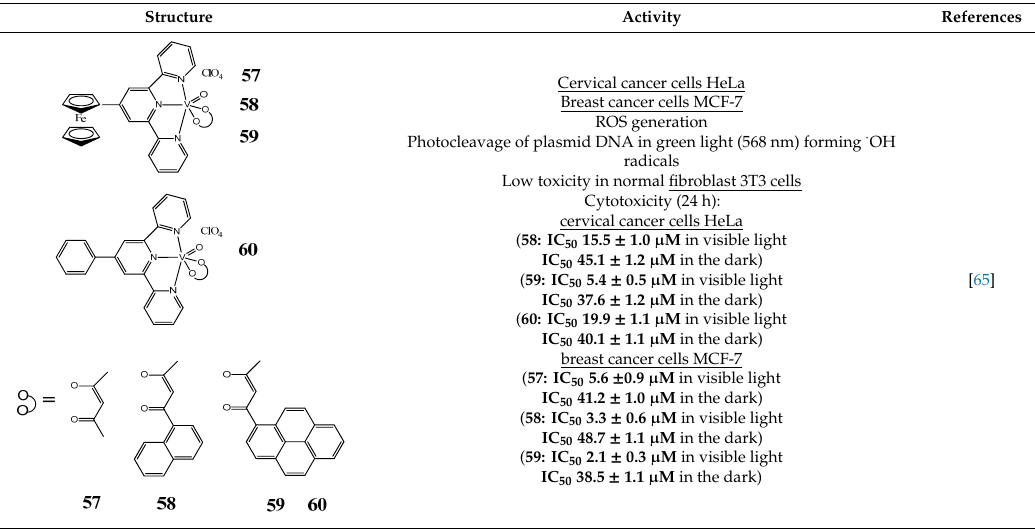
Table 2. Cont. Structure